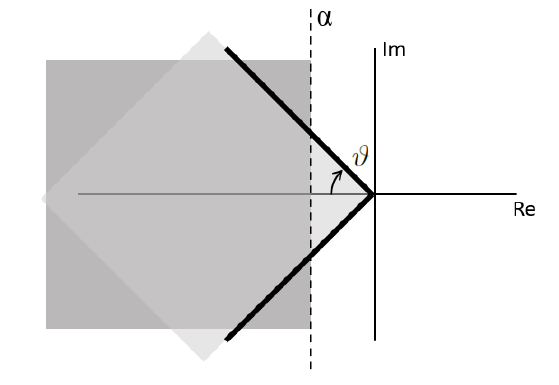
Figure 9. LMI regions in the pole